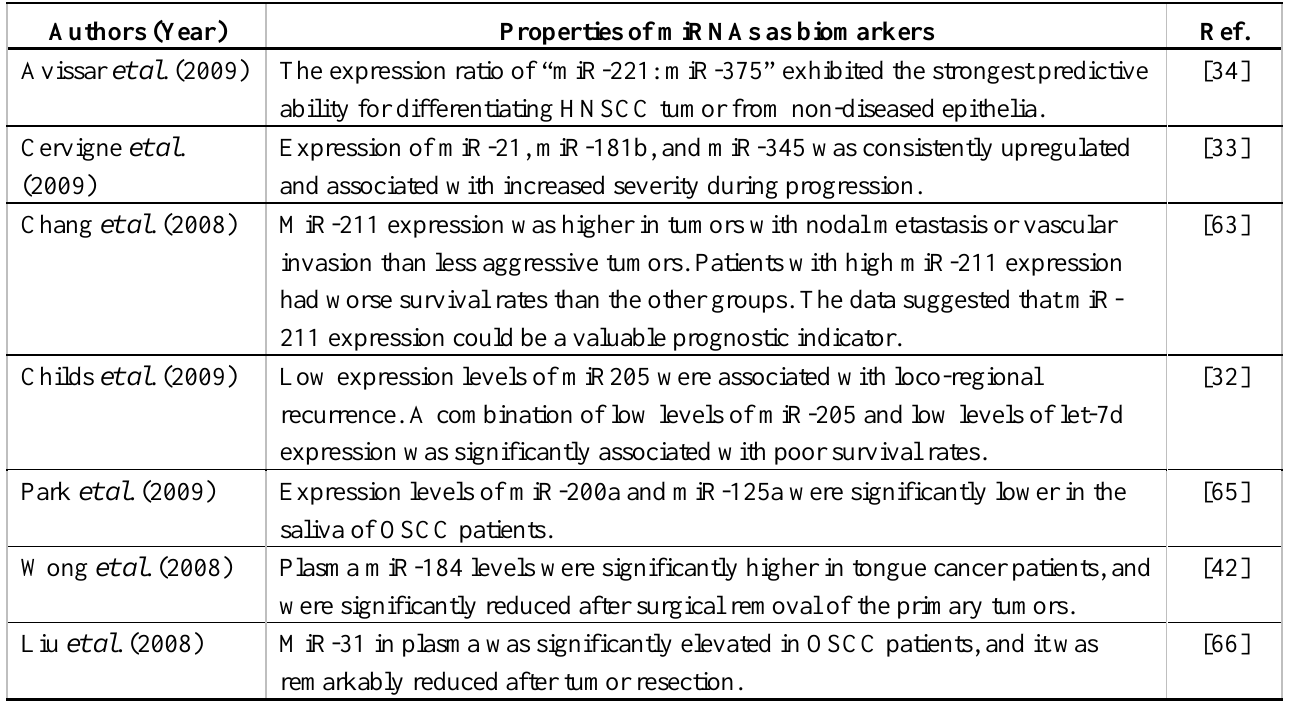
Table 3. Properties of miRNAs as biomarkers in HNSCC/OSCC reported in the recent